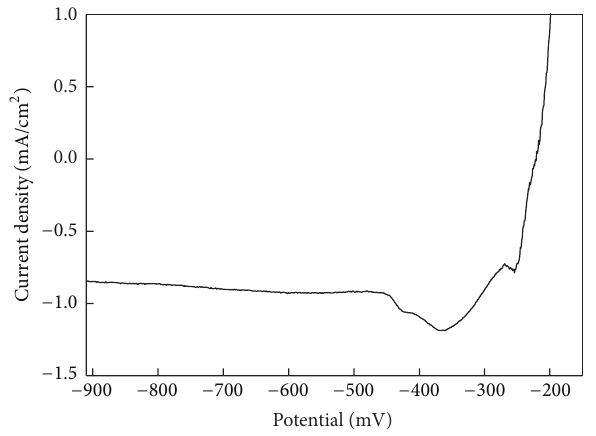
Figure 1: Polarization curve was conducted to determine the reduction potentials of each element (scan rate = 1mV/s).